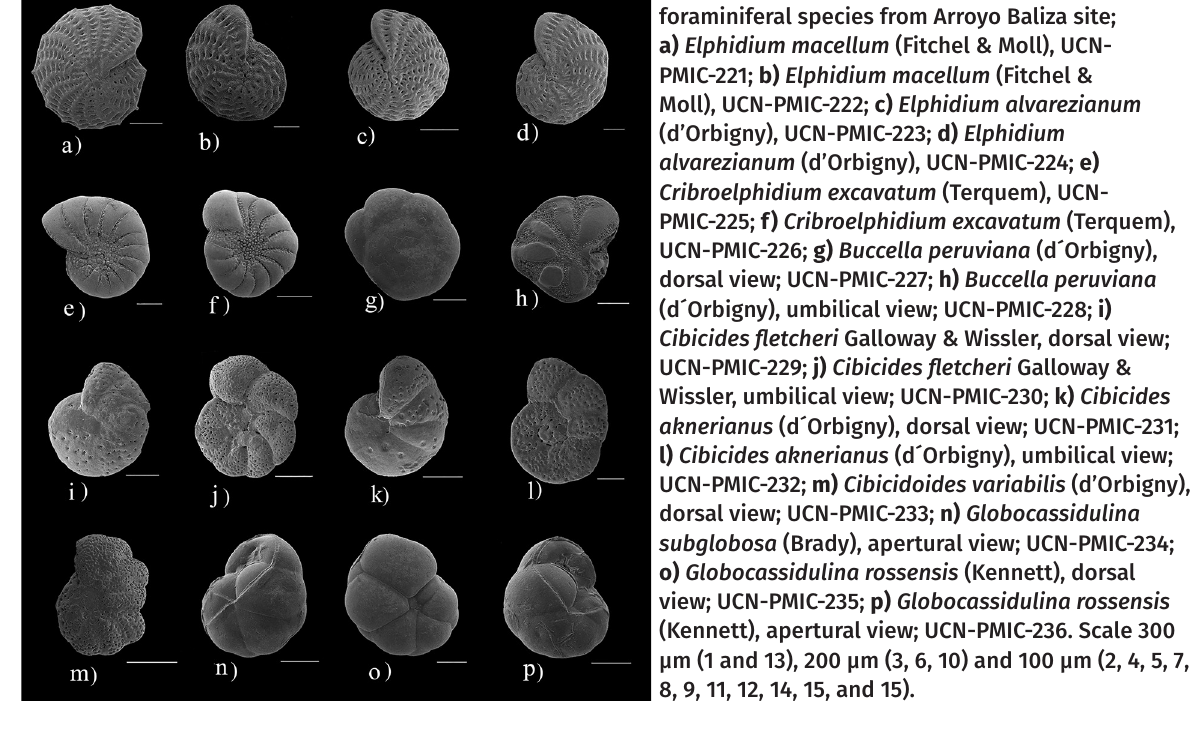
Figure 2. Photomicrographs of the most important foraminiferal species from Arroyo Baliza site; a) Elphidium macellum (Fitchel & Moll), UCN- PMIC-221; b) Elphidium macellum (Fitchel & Moll), UCN-PMIC-222; c) Elphidium alvarezianum (d’Orbigny), UCN-PMIC-223; d) Elphidium alvarezianum (d’Orbigny), UCN-PMIC-224; e) Cribroelphidium excavatum (Terquem), UCN- PMIC-225; f) Cribroelphidium excavatum (Terquem), UCN-PMIC-226; g) Buccella peruviana (d´Orbigny), dorsal view; UCN-PMIC-227; h) Buccella peruviana (d´Orbigny), umbilical view; UCN-PMIC-228; i) Cibicides fletcheri Galloway & Wissler, dorsal view; UCN-PMIC-229; j) Cibicides fletcheri Galloway & Wissler, umbilical view; UCN-PMIC-230; k) Cibicides aknerianus (d´Orbigny), dorsal view; UCN-PMIC-231; l) Cibicides aknerianus (d´Orbigny), umbilical view; UCN-PMIC-232; m) Cibicidoides variabilis (d’Orbigny), dorsal view; UCN-PMIC-233; n) Globocassidulina subglobosa (Brady), apertural view; UCN-PMIC-234; o) Globocassidulina rossensis (Kennett), dorsal view; UCN-PMIC-235; p) Globocassidulina rossensis (Kennett), apertural view; UCN-PMIC-236. Scale 300 µm (1 and 13), 200 µm (3, 6, 10) and 100 µm (2, 4, 5, 7, 8, 9, 11, 12, 14, 15, and